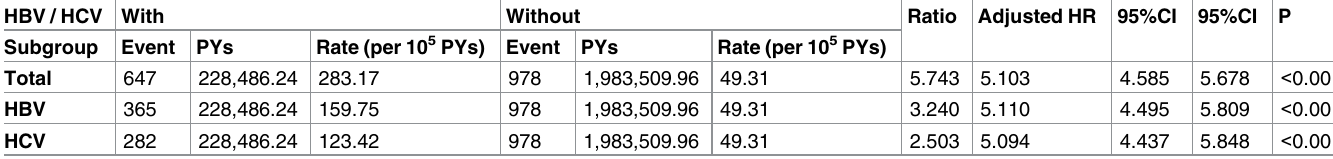
PYs, person-years; adjusted HR, adjusted hazard ratio: adjusted for the variables listed in the Cox regression table; CI, confidence interval; HBV, hepatitis B virus; HCV, hepatitis C